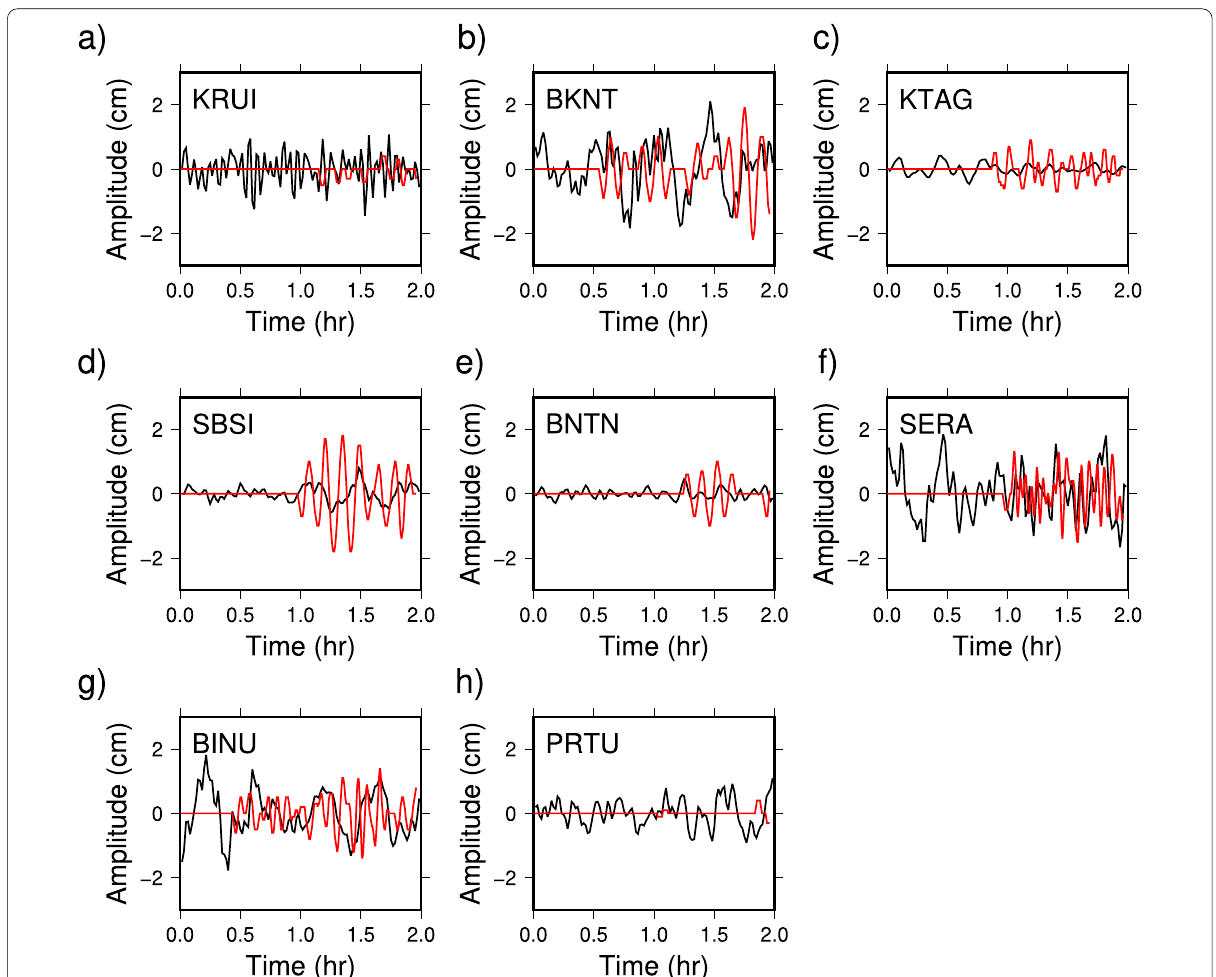
Fig. 4 Tide gauge data record and waveform model of fault Model 1A at each tide gauge station. The data after filtering using a de-tiding and moving average process are shown by the black line. The waveform model of fault Model 1A is shown by the red line. The tide gauge stations are: a KRUI, b BKNT, c KTAG, d SBSI, e BNTN, f SERA, g BINU, and h